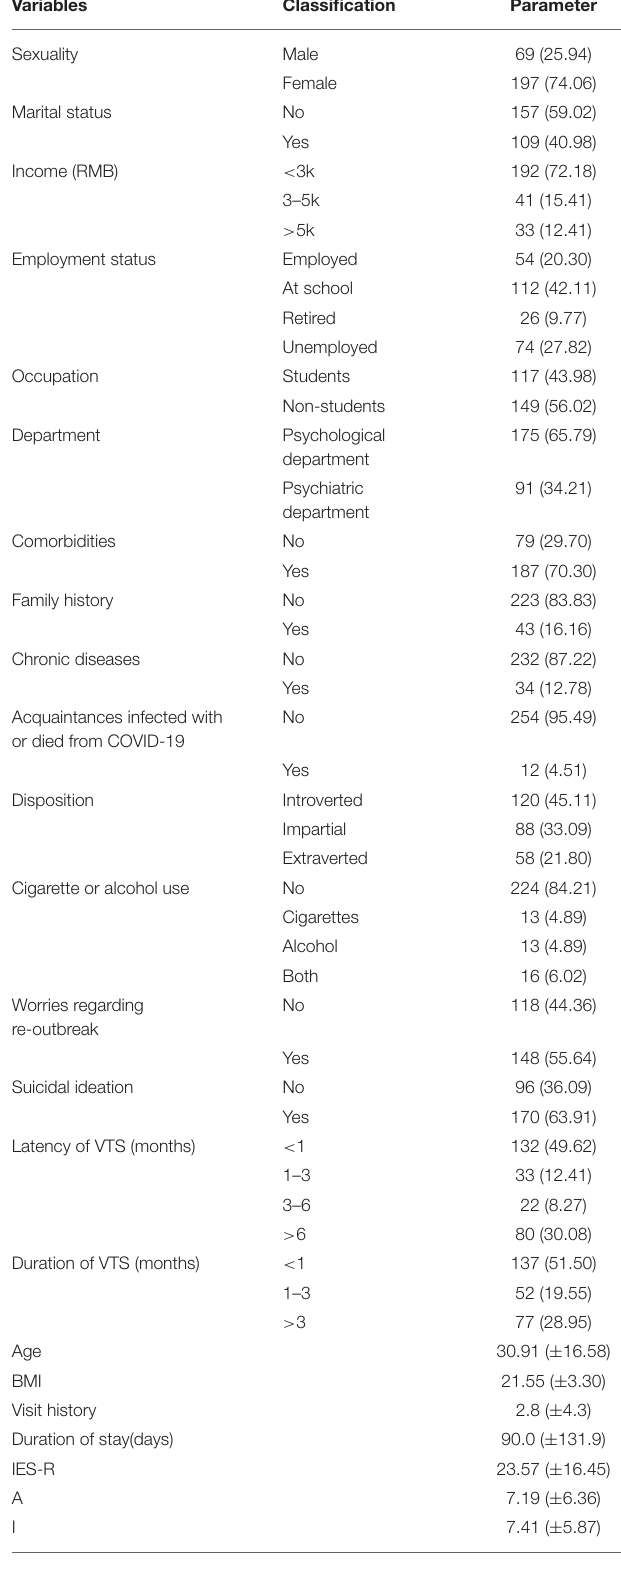
TABLE 1 | Socio-demographic characteristics captured in our sample of